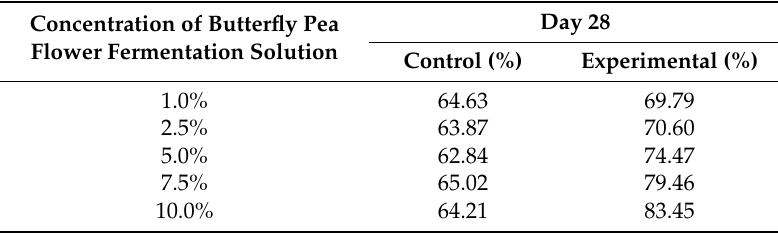
Table 4. Whitening values of the fermentation solution at different concentrations after 28 days of